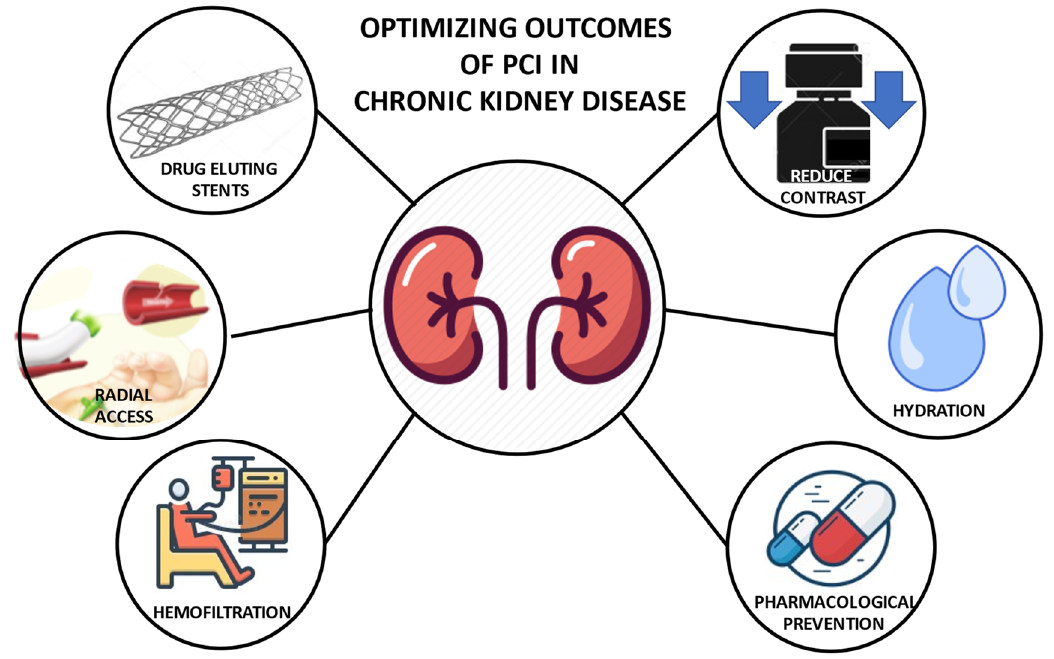
Figure 1. Strategies to optimize PCI outcomes in patients with chronic kidney disease.